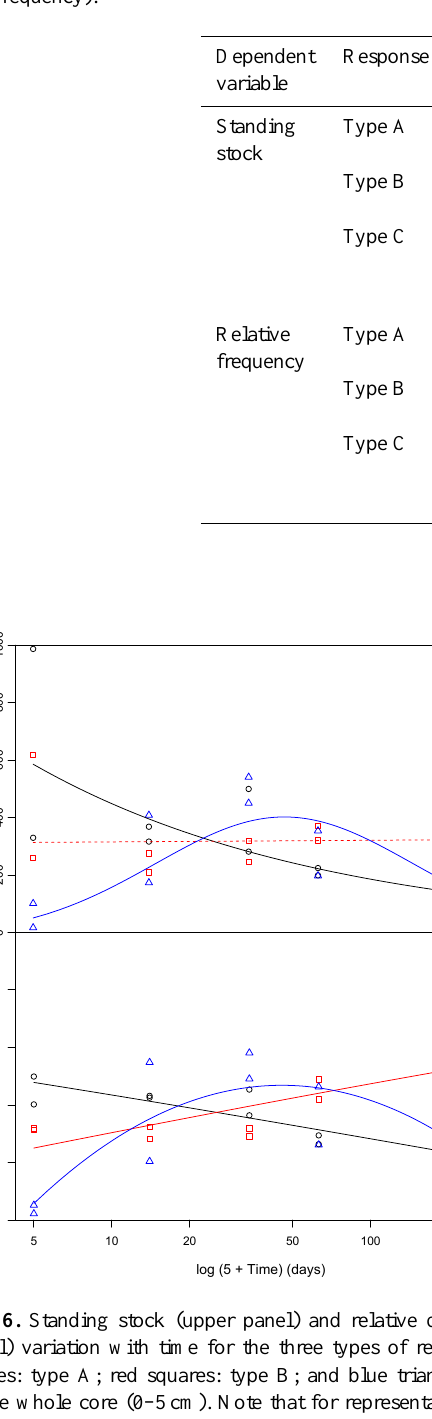
Table 9. Statistical parameters (Df: degrees of freedom; Sum Sq: sum of squares; Mean Sq: mean of squares; F value: value of the F test; Pr ( >F ): probability of the F test) for the model-type 3 for all three response types and for the two tested dependant variables (standing stock and frequency).